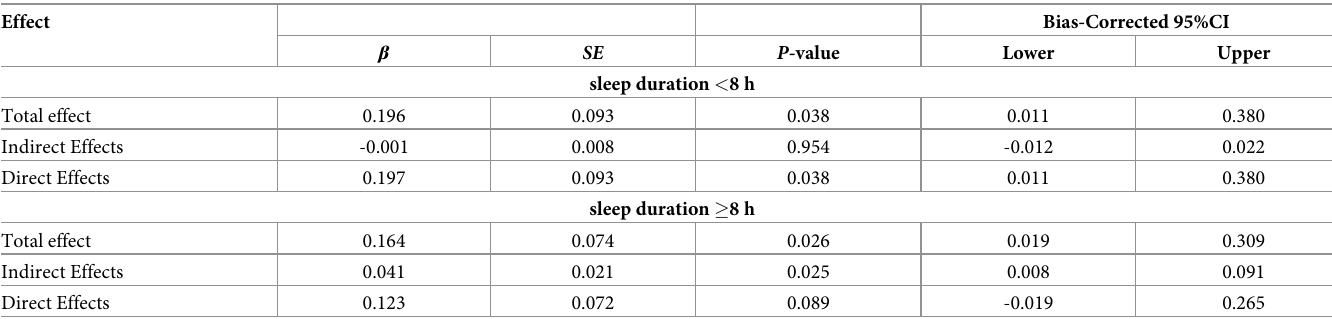
Table 5. The mediation model of social cohesion stratified by sleep duration a